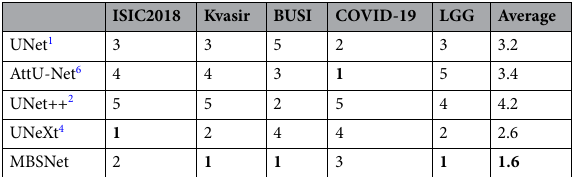
Table 3. Best model ranking. Significant values are in [bold]. MBSNet and other comparison models are ranked by TOPSIS scores on multiple